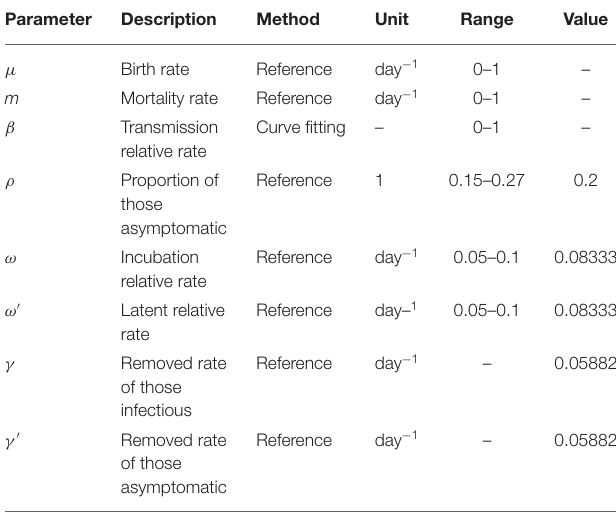
TABLE 1 | Description and source of parameters in the SEIAR